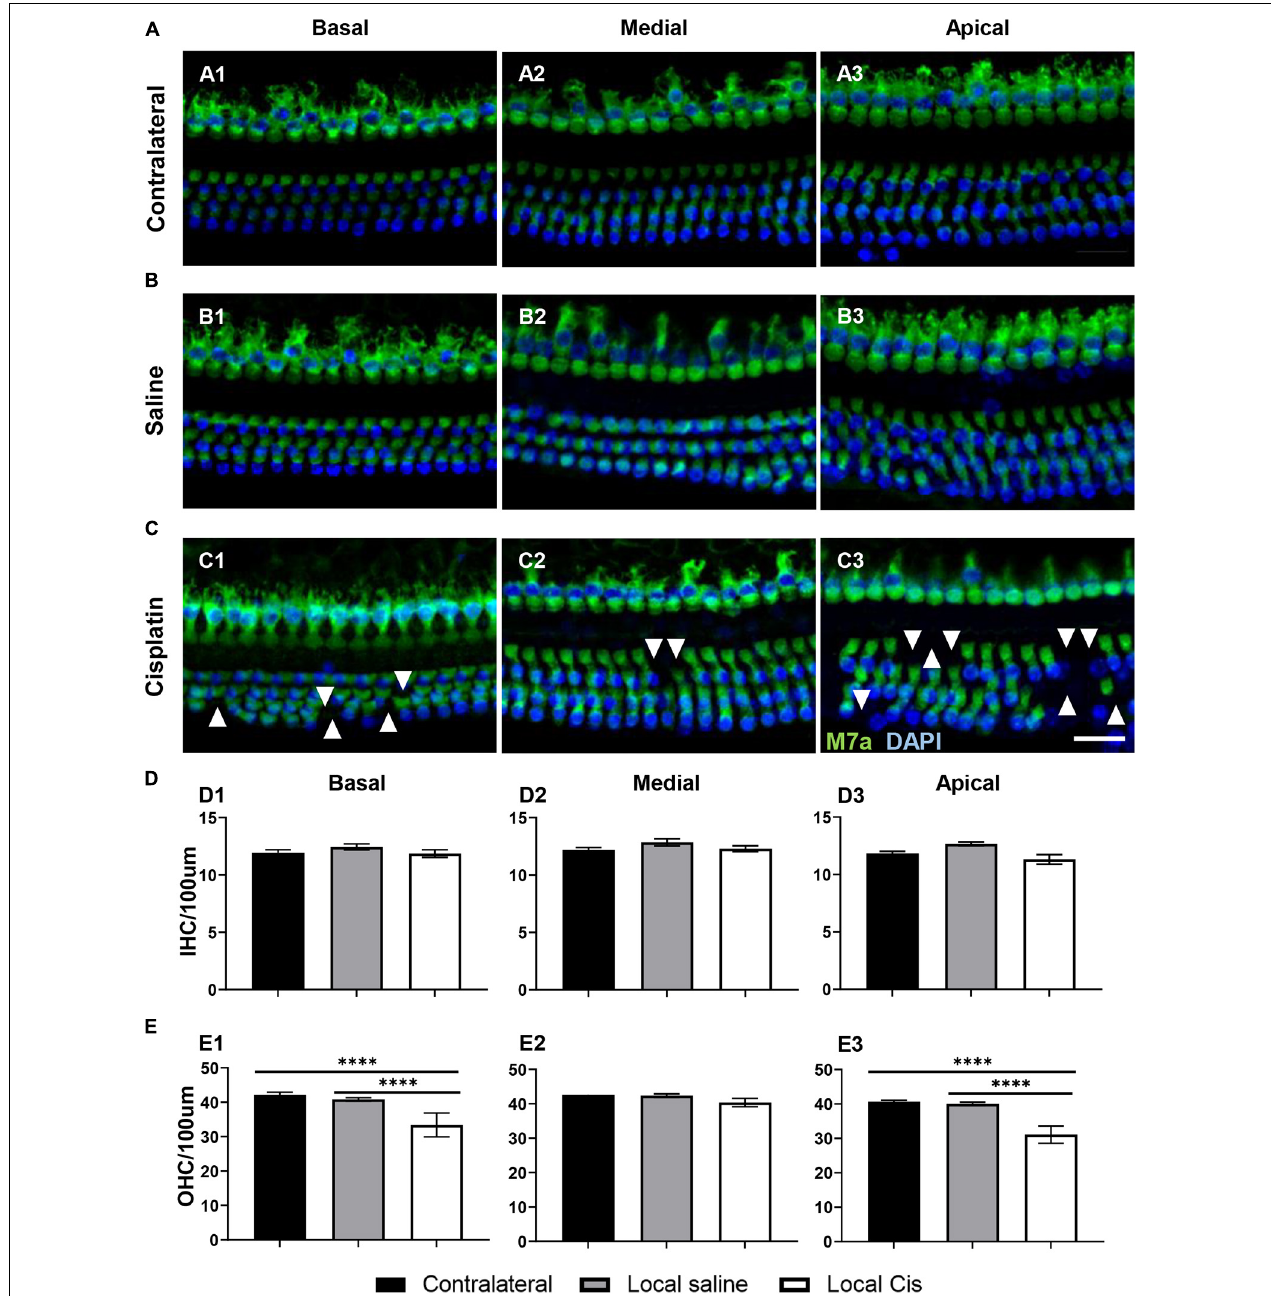
FIGURE 2 | Effects of cisplatin local delivery on IHC and OHC viability. Cytocochleogram showing both IHC and OHC, quantified in a representative area of 100- µ m length from basal, medial, and apical cochlear turns, in (A) contralateral, (B) saline, and (C) local-cisplatin (5 mM) cochleae. Samples were stained for 4 (cid:48) ,6-diamidino-2-phenylindole (blue) and myosin VIIa (green). (D) Bar graphs show number of IHC/100 µ m area in (D1) basal, (D2) medial, and (D3) apical turns of cochlea (without subgroup distinction). (E) Bar graphs show number of OHC/100 µ m area in (E1) basal, (E2) medial, and (E3) apical turns of cochlea (without subgroup distinction). White arrows indicate missing hair cells. Scale bar: 20 µ m. n = 15. The confidence interval for both statistics was set as 95% ( a = 0.05); ∗∗∗∗ p <